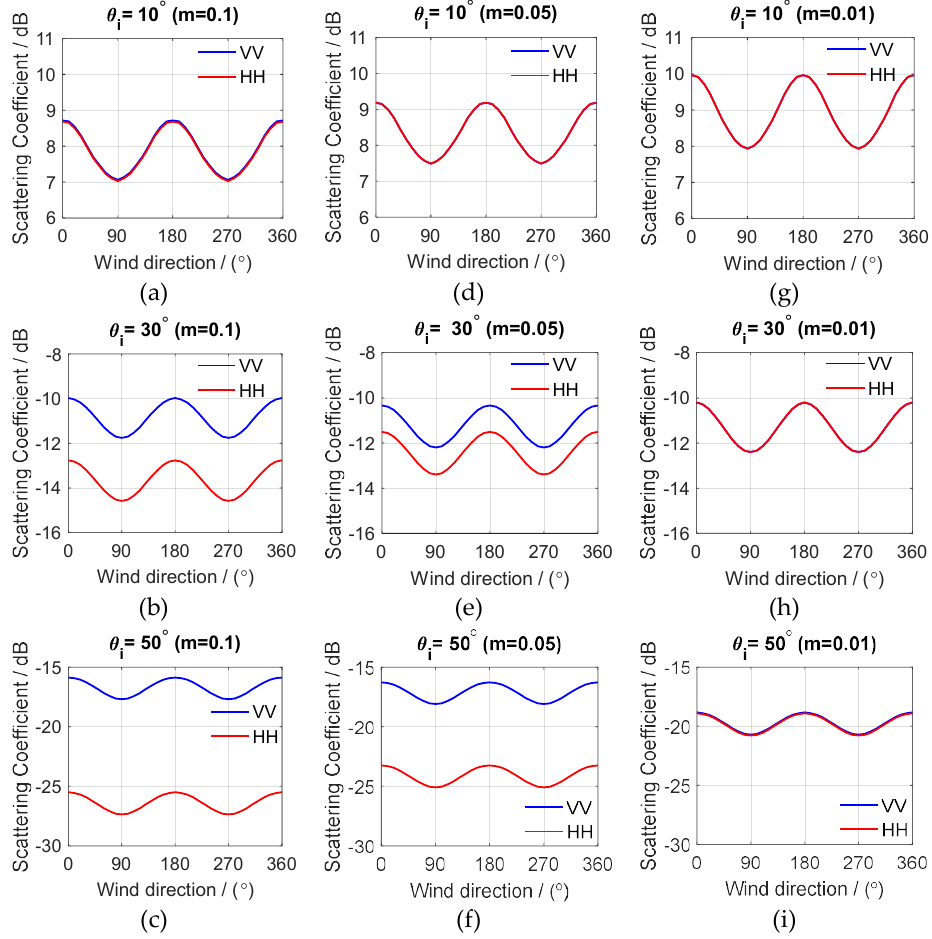
Figure 4. The theoretical backscattering behaviors relative to wind direction versus m at wind speed of 10 m/s with incident angles of 10, 30, and 50 degrees. ( a )–( c ) m = 0.1; ( d )–( f ) m = 0.05; ( g )–( i ) m = 0.01.